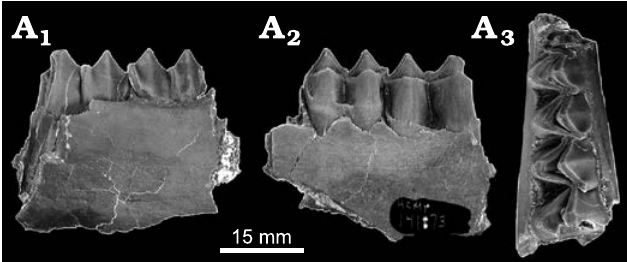
Fig. 3. Merycoidodontid artiodactyl Ticholeptus sp. indet. from locality UCMP V70142, Eastgate Churchill County, Nevada, USA; early Barsto- vian, middle Miocene. UCMP 141873, partial left dentary fragment with complete m1 and partial m2 in lingual (A 1 ), labial (A 2 ), and occlusal (A 3 )